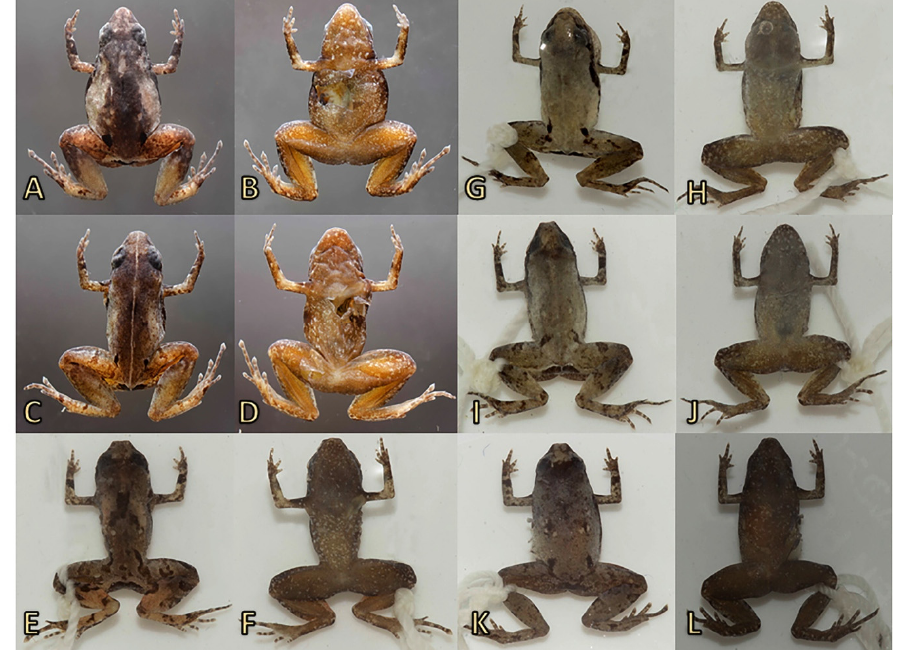
Figure 5. Photographs of preserved specimens of Noblella losamigos sp. n. ( A , B ) Adult female holotype MUSA 6973 (SVL 10.7 mm); ( C , D ) adult male paratype MUSA 6974 (SVL 9.8 mm); ( E, F ) adult male paratype MUSM 37355 (SVL 9.5 mm); ( G, H ) adult male paratype UMMZ 246569 (SVL 9.6 mm); ( I , J ): adult female paratype MUSM 37356 (SVL 9.7 mm); and ( K , L ) adult female paratype UMMZ 246570 (SVL 11.3 mm). Photographs by Rudolf von May, Roy Santa-Cruz, and Courtney Whitcher.